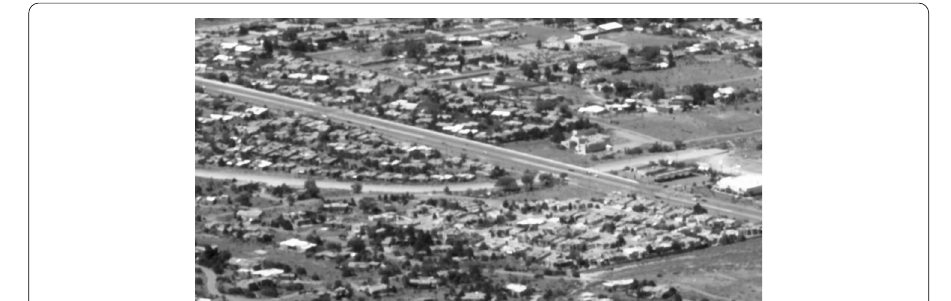
Fig. 1 A cropped image captured by the video